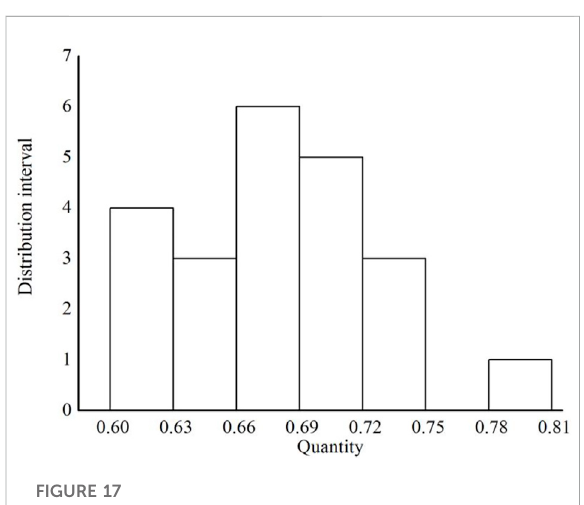
FIGURE 17 Ratio statistical chart of crack initiation and peak